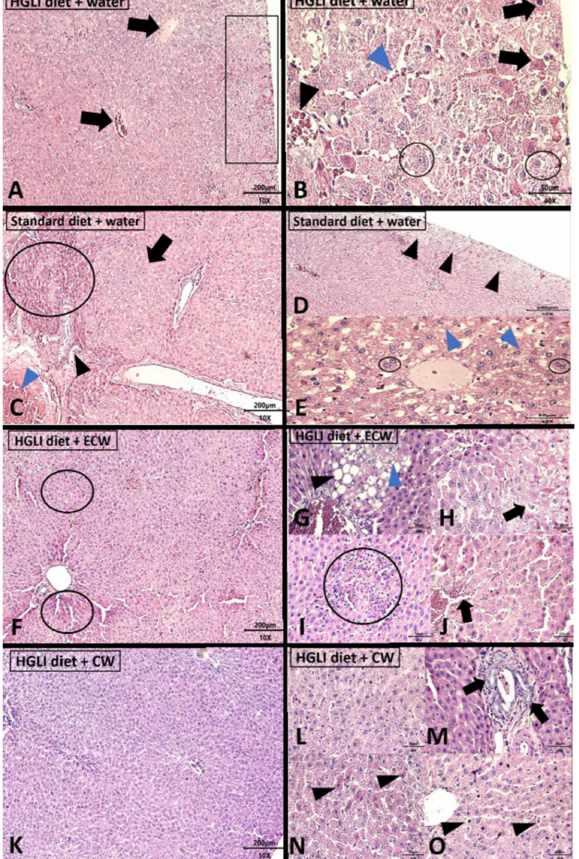
Figure 3. Histopathological analysis Wistar rats livers stained with hematoxylin and eosin (H,E). ( A,B ): HGLI diet + water ( n = 5); ( C – E ): standard diet + water ( n = 5); ( F – J ): HGLI diet + ECW ( n = 5); ( K – O ): HGLI diet + CW. ( A ): Panoramic evidence of the liver, with the presence of dilated blood vessels due to hyperemia (black arrow), in addition to an area of ballooning degeneration and hepatocytes suggestive of necrosis (black rectangle) in the peripheral organ portion (H,E-10 × objective). ( B ): Presence of hepatocytes suggestive of necrosis (black arrows); hepatocytes showing ballooning degeneration (black circles); evidence of sinusoidal capillaries dilatation (blue arrowhead); hyperemia in the centrilobular vein (black arrowhead) (H,E-40 × objective). ( C ): extensive area of hepatocytes suggestive of necrosis (black circle); evidence of pseudolobule (black arrow); bile ductal proliferation (black arrowhead); intense hyperemia (blue arrowhead) (H,E- 10 × objective). ( D ): an external band of ballooning degeneration (black arrowheads) (H,E-10 × objective). ( E ): the presence of binucleated hepatocytes (black circle) and microvesicular steatosis (blue arrowhead) (H,E-40 × objective). ( F ): liver panoramic view, showing few areas of necrosis (black circles) (H,E-10 × objective). ( G ): evidence of